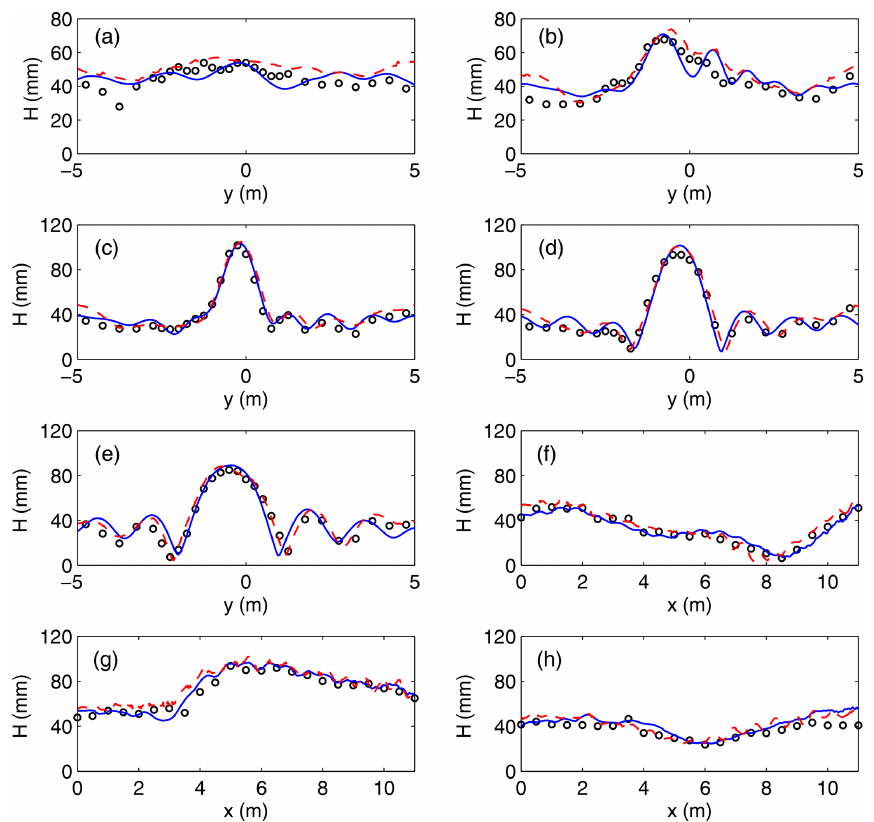
Figure 10. Experimental benchmark of Fig. 8. Comparison of wave height distribution along transects (a) – (h) in (circles) experimental data and results of the (dashed) single-grid and (solid) nested-grid